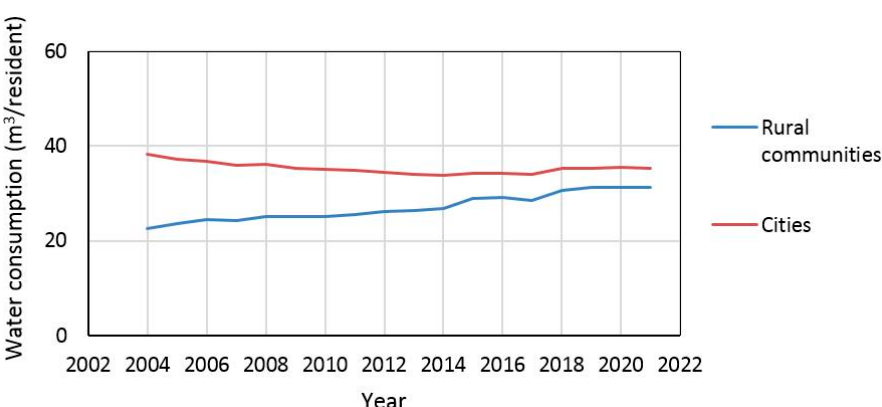
Figure 7. Annual tap water from water supply network consumption per 1 resident, data obtained from [66].